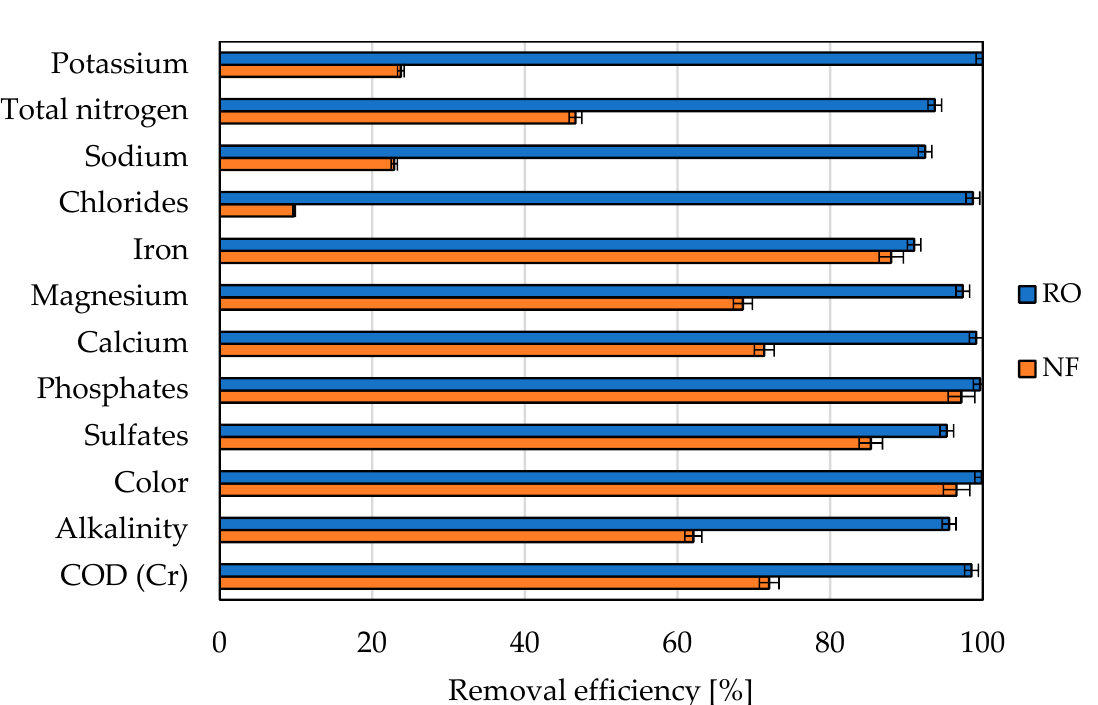
Figure 6. The removal efficiency of the selected compounds during high-pressure filtration; PCI NF membrane and PCI RO membrane, T = 25 °C, Δ P = 3.0 MPa.